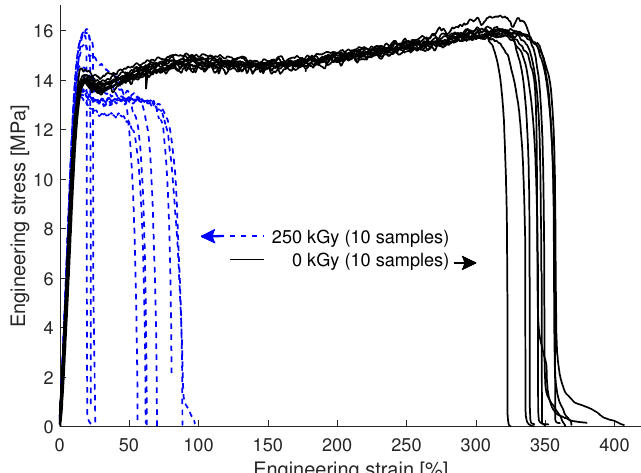
Figure 9. Results of the tensile experiments of the FEP VDA foils exposed to electron irradiation doses of 0kGy and 250kGy. For each irradiation dose 10 samples have been tested. The irradiated samples show a reduction of the ultimate tensile strain to about 7–25% of the value of non-irradiated samples. Furthermore, the irradiated samples exhibit an increased scatter of the yield